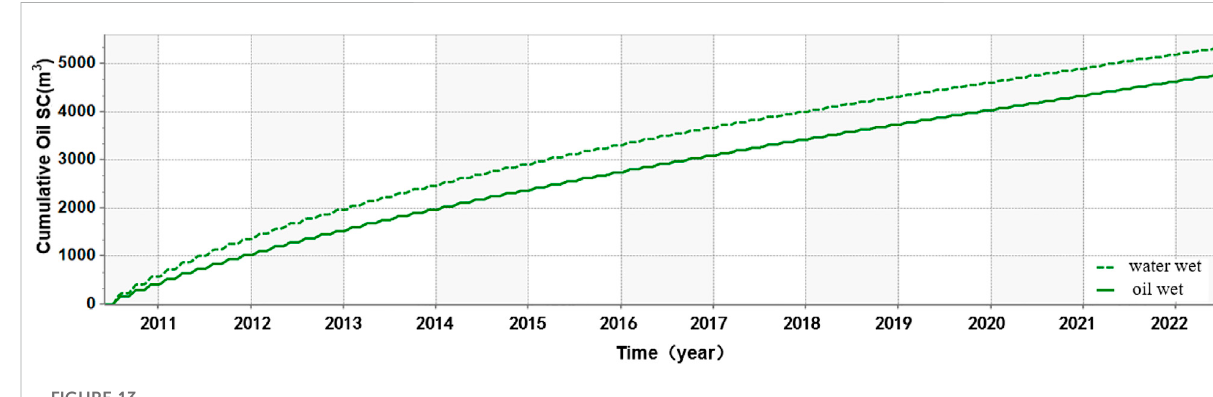
FIGURE 13 Cumulative oil recovery of reservoirs with different wettability.